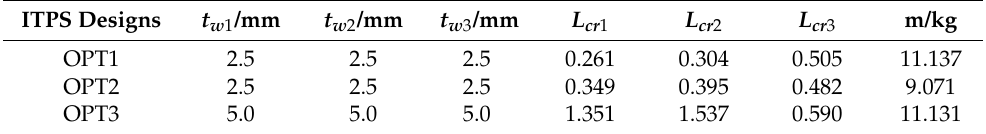
Table 3. Comparison of critical load factor between three ITPS